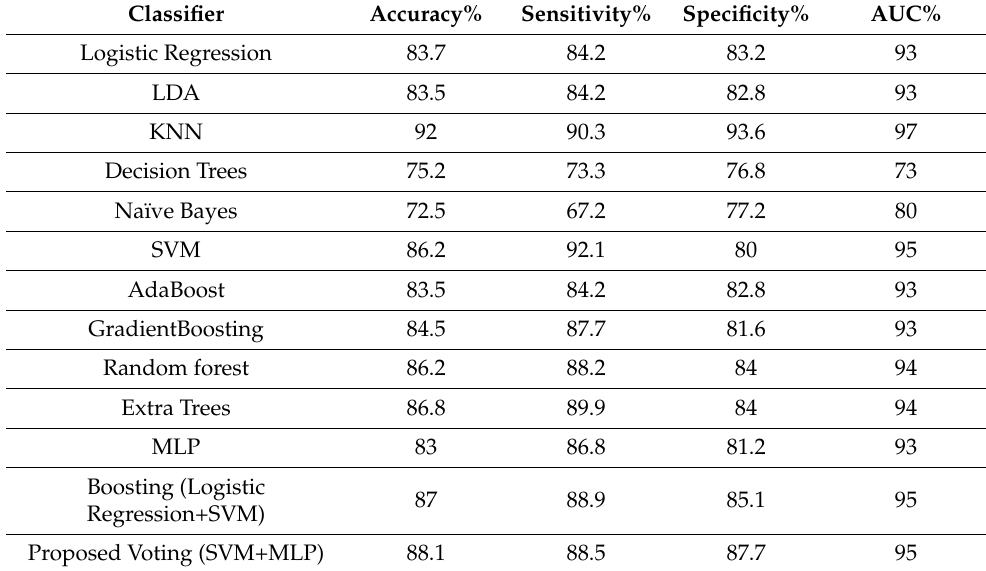
Table 3. Results of Each